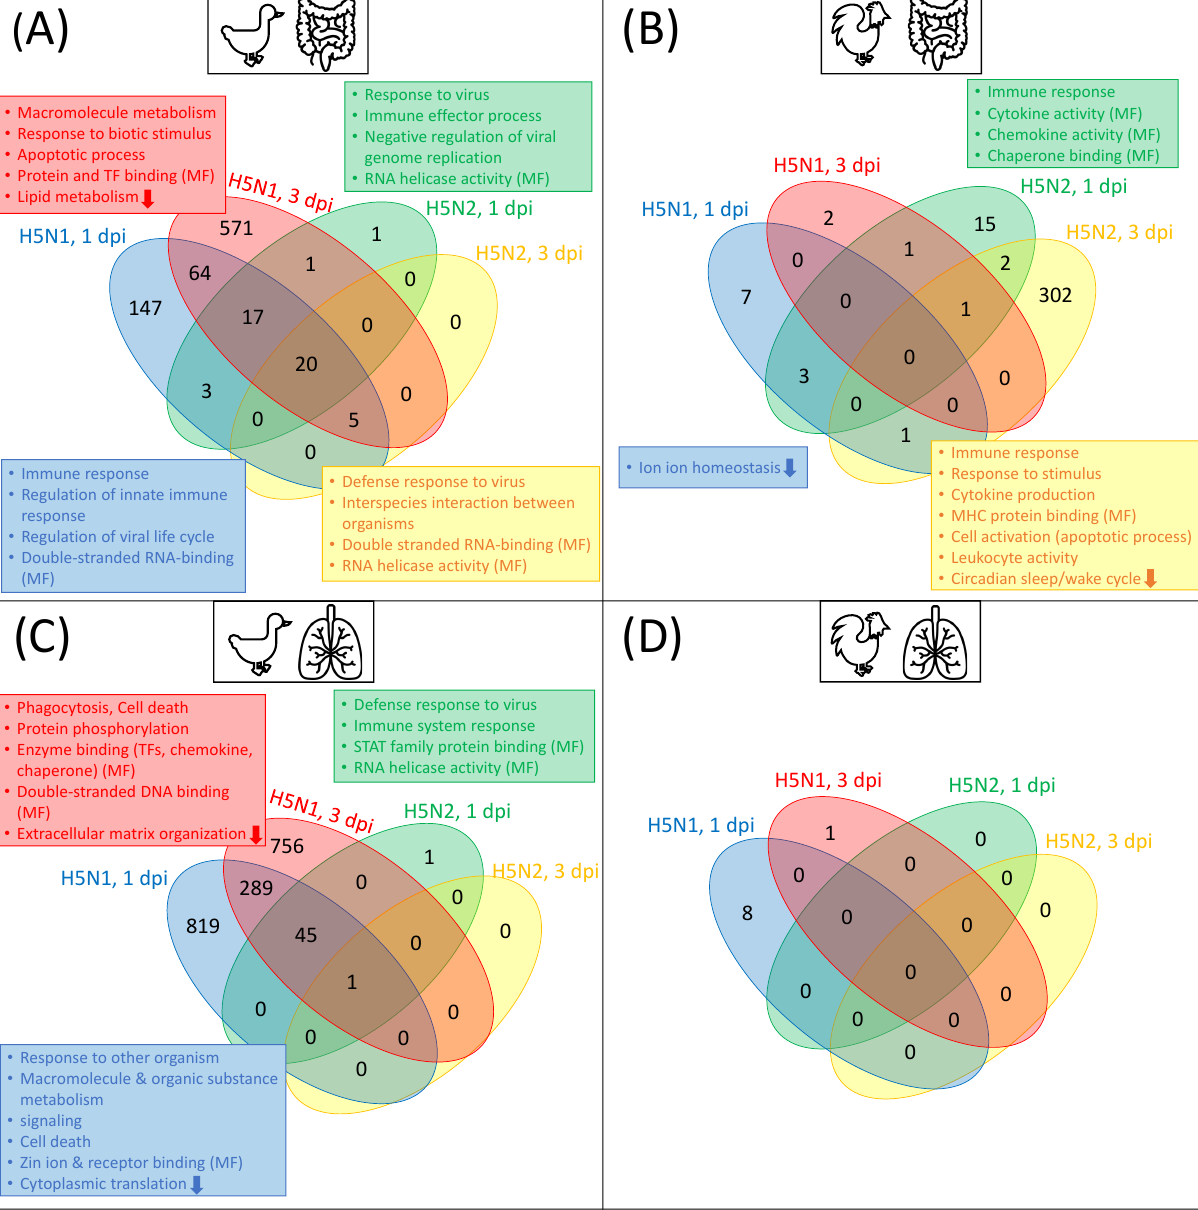
Figure 2. Venn diagrams of the DEGs ( A ) duck in ileum, ( B ) chicken in ileum, ( C ) duck in lung, and ( D ) chicken in lung with selected enriched Gene Ontology (GO) terms. The DEGs are obtained by comparing animals infected with AIV (H5N1 (HPAI) or H5N2 (LPAI)) with mock-infected animals. The colors within the venn diagram, as well as the colors of the GO-term boxes, stand for the respective condition: blue represents H5N1 infection 1 dpi, red represents H5N1 infection 3 dpi, green represents H5N2 infection 1 dpi, and yellow represents H5N2 infection 3 dpi for each species and tissue. Within the boxes, an arrow down indicates that the GO-term is enriched among the downregulated DEGs; otherwise, the terms are enriched among the upregulated DEGs. The GO-terms represent biological processes except, if stated differently, in the form of MF (molecular function). Venn diagrams are based on the data provided in Table